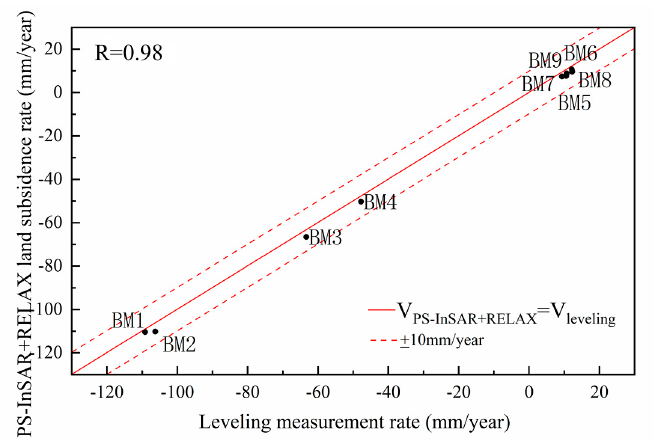
Figure 14. Comparisons of PS-InSAR+RELAX obtained land subsidence rates and leveling measurement rates from 2014 to 2016. The location of benchmarks is marked as “BM1-BM9” (see Figure 2).